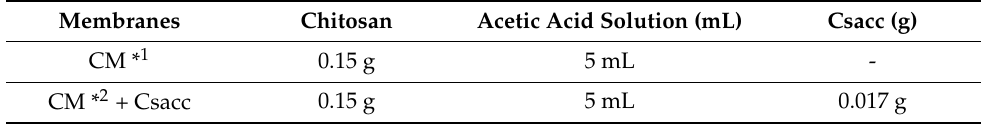
Table 1. Membranes based on chitosan and other components.